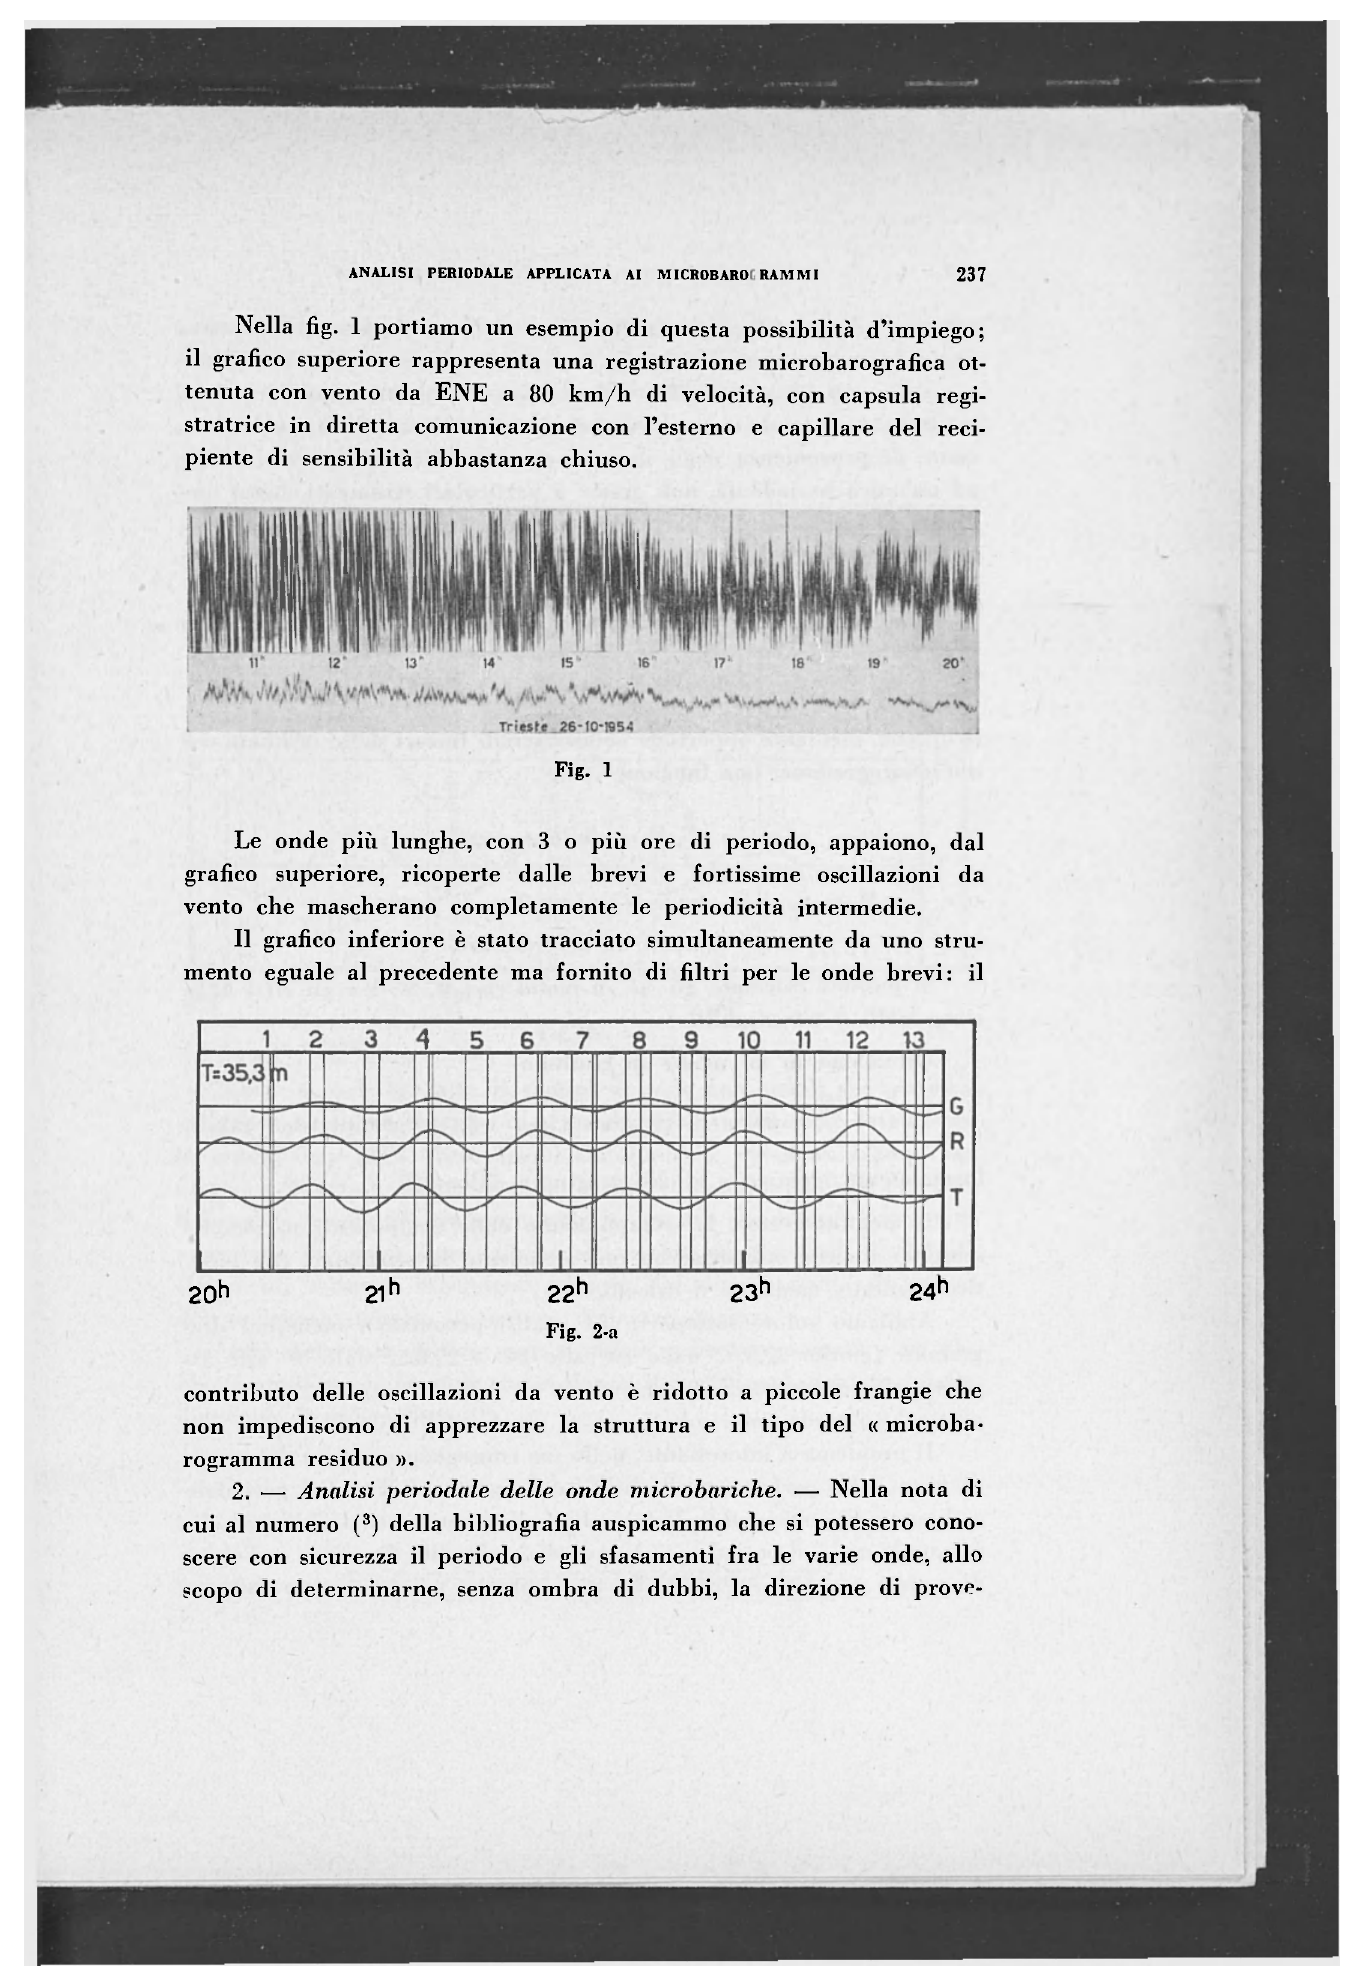
periodale delle onde